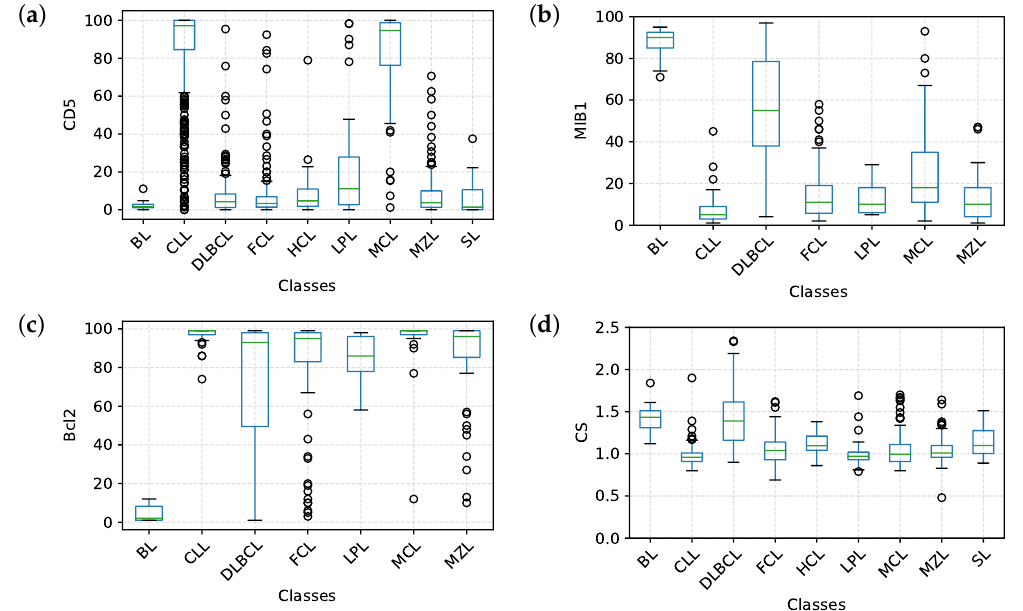
Figure 4. Distribution of CD5 ( a ), MIB1( b ), Bcl2 ( c ) and CS ( d ) in all the samples of the database, versus B-NHL subclass. HCL and SL samples are not represented in MIB1 and Bcl2 plots because samples from these two classes have not been consistently evaluated for these two markers. Each box has a central mark that indicates the median of the distribution, whereas bottom and top edges of the box indicate the 25th and 75th percentiles, respectively. The whiskers extend to the most extreme non-outliers data points. Circle markers indicate outliers. CS stands for cell